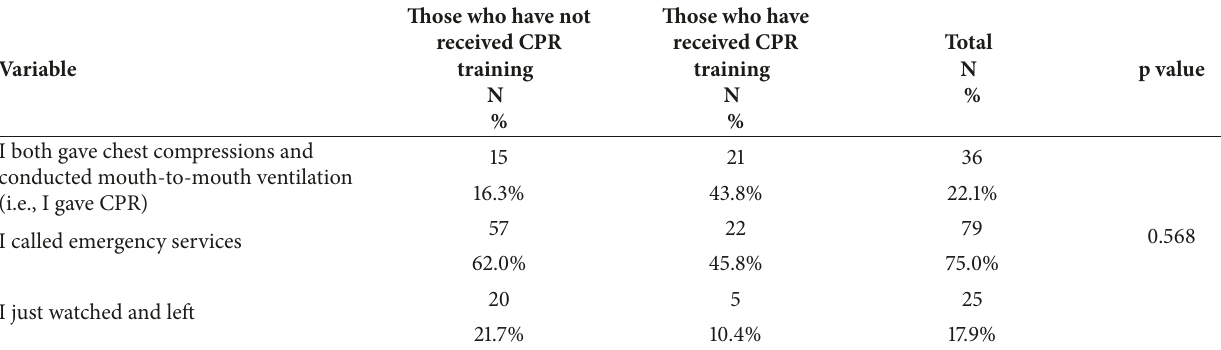
Table 9: Association between the actions performed to a witnessed cardiac arrest with previous CPR training.